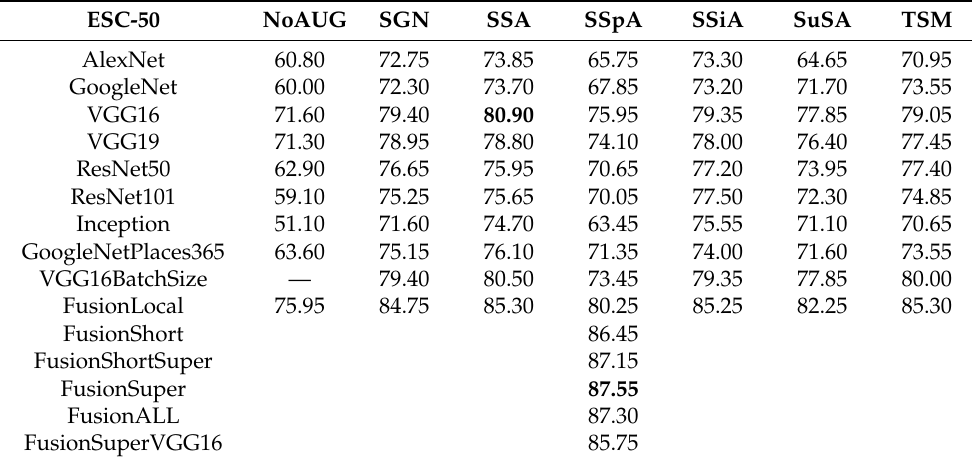
Table 4. Performance on the ESC-50 (mean accuracy over the five-fold cross-validation). Values of interest are in